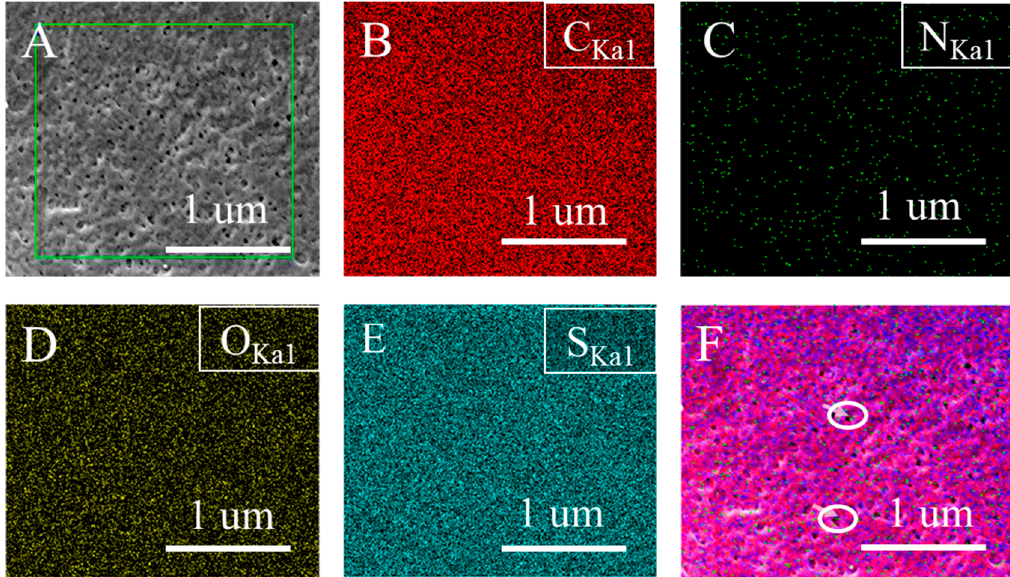
Figure 5. ( A ) The SEM micrograph of the top surface of B2 32:1 membrane and the corresponding elemental mapping analyses of ( B ) Carbon, ( C ) Nitrogen, ( D ) Oxygen, ( E ) Sulfur. ( F ) mixed distribution of all elements (N is in bright green).